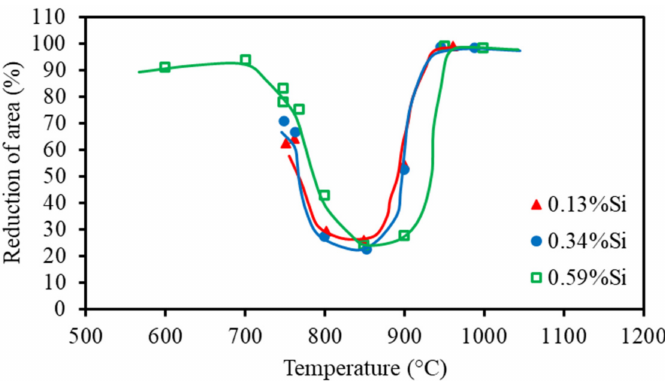
Figure 23. Influence of Si on the hot ductility curves of plain 0.1% C, 1.2% Mn steels (Al free) having 0.011% N. Curves move to higher temperatures with increasing Si level [60].